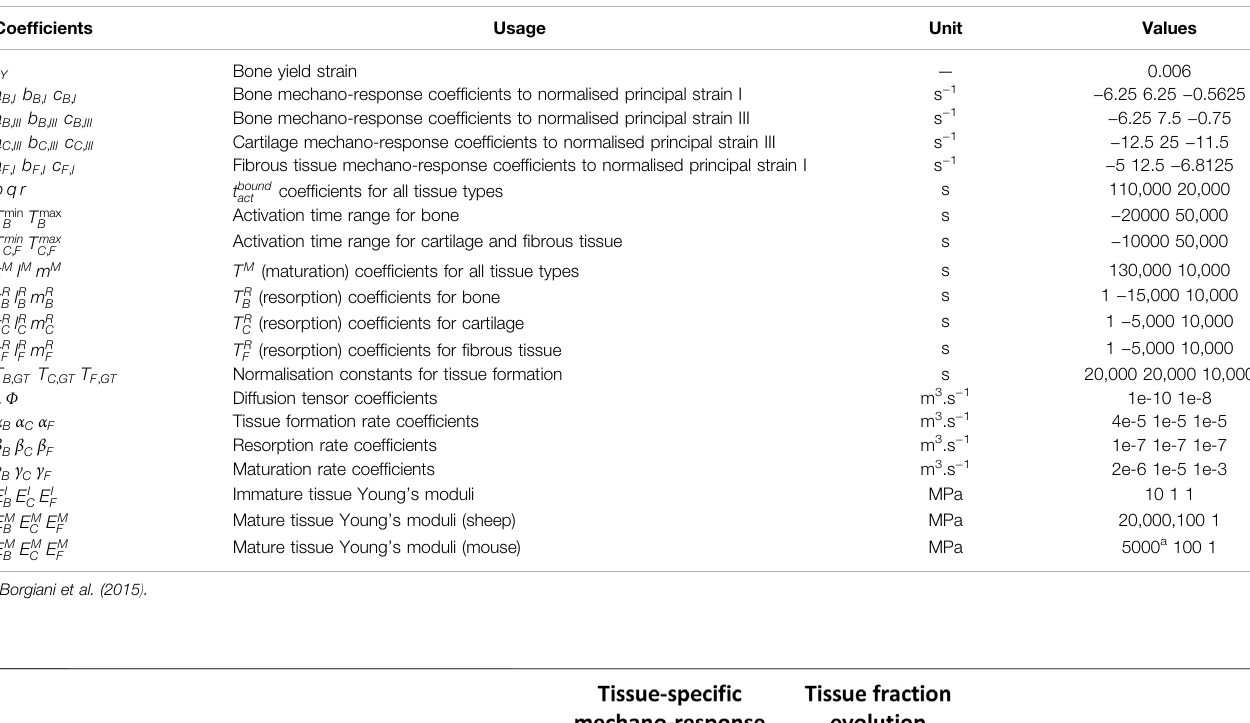
TABLE 1 | Computer model parameters [adapted from (Frame et al., 2017)].